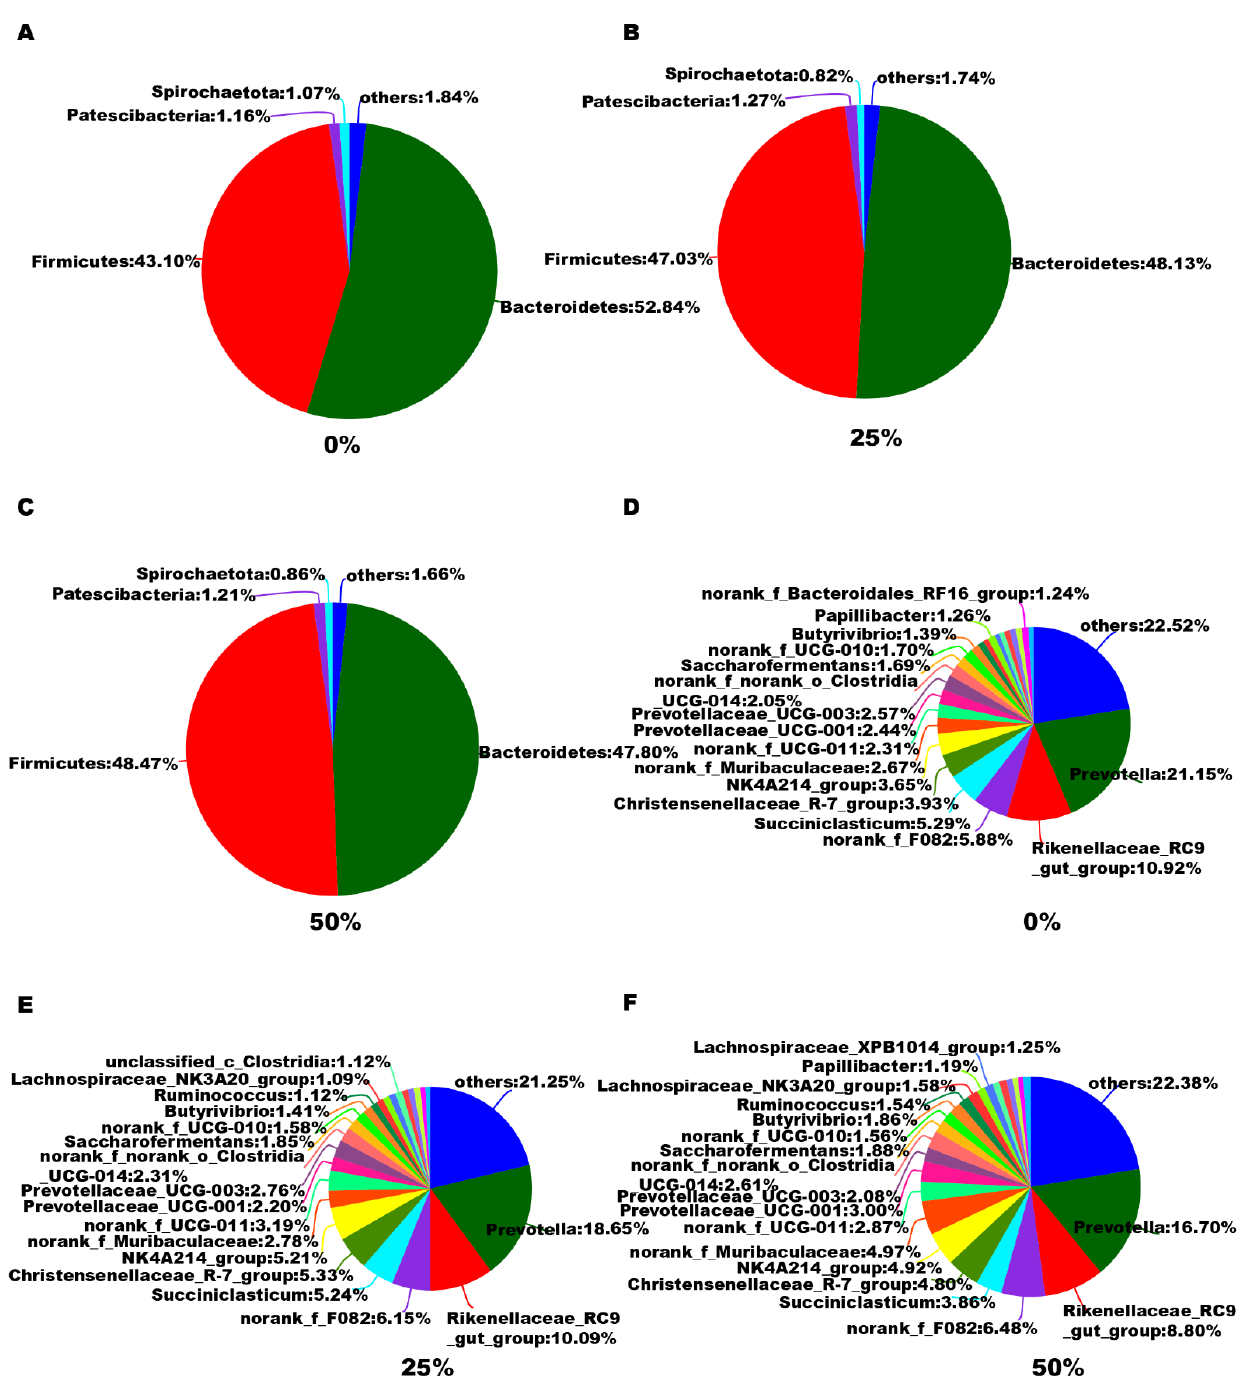
Figure 2. Effect of different proportions of hydroponic barley seedlings replacing oat hay on the distribution of bacterial taxa averaged under phyla ( A – C ) and genera ( D – F ) in heifers. Correlation analysis between the ruminal microbial profiles and nutrient digestibility is presented in Figure 3. The apparent digestibility of CP ( p < 0.01, r = −0.61) and EE ( p < 0.01, r = −0.58) was negatively correlated with Lachnospiraceae_XPB1014_group . The appar- ent digestibility of OM ( p = 0.01, r = −0.55), NDF (p = 0.01, r = −0.56), ADF ( p = 0.02, r = −0.52), and CP ( p < 0.01, r = −0.61) was negatively correlated with Bacillus . The apparent